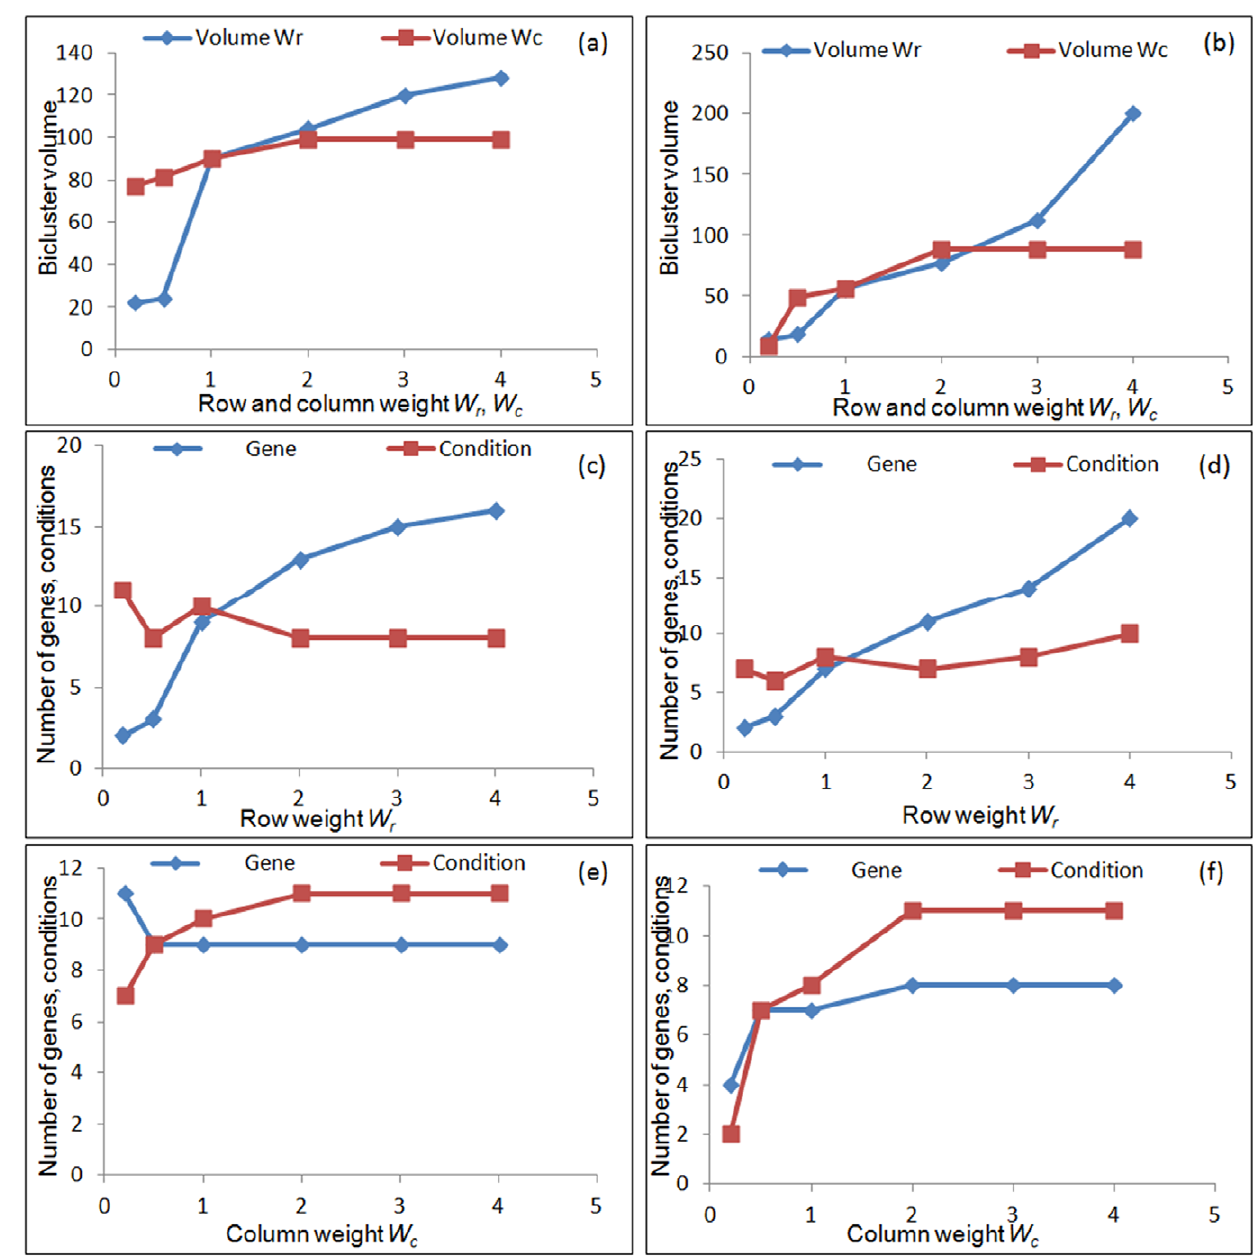
Figure 4. Effect of model parameters on features of optimal bi-cluster. (a-b) Variation of bi-cluster volume with change in row and column weights ( W r , W c ) for 2-D (a) and 3-D (b) experiments. In both cases changing W r was found to change the bi-cluster volume considerably, while it was less sensitive to changes in W c . The bi-cluster volume was further analyzed separately as rows and columns depicting genes and conditions. (c-f) Variation of number of genes and conditions in the optimum bi-cluster as a function of row weight (c,d) and column weight (e,f) for 2-dimensional culture (c,e) and 3-dimensional culture (d,f). This indicates the possibility of tailoring the bi-clusters by biasing the analysis towards genes or conditions by modifying the row and column